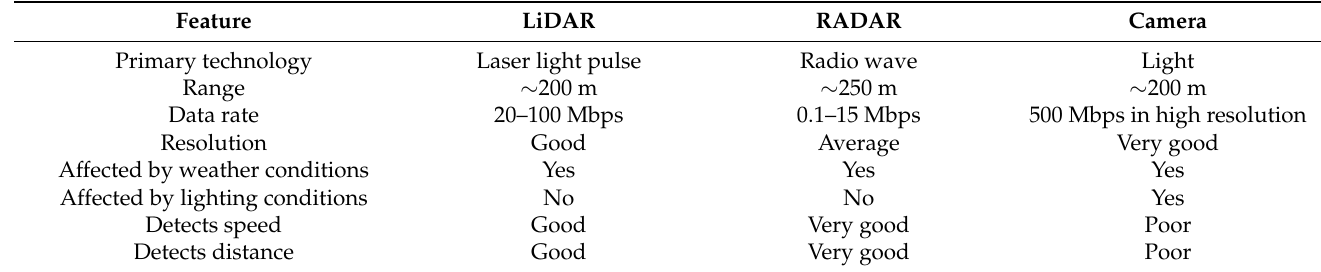
Table 2. Summary of autonomous vehicles’ sensors